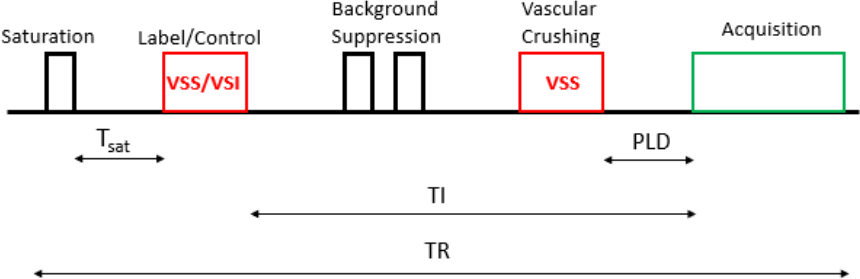
Figure 5. Schematic representation of the VSASL sequence. PLD: post-labeling delay; TI: inversion time; TR: repetition time.